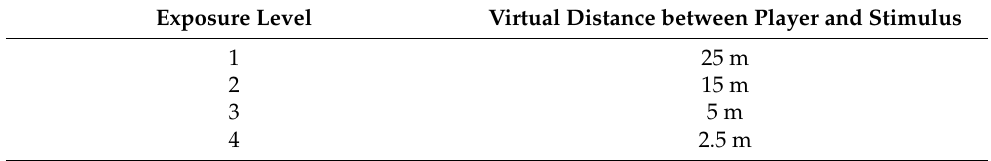
Table 1. Exposure hierarchy. Each exposure level corresponds to the distance between the participant and the virtual sound source; distance is represented in